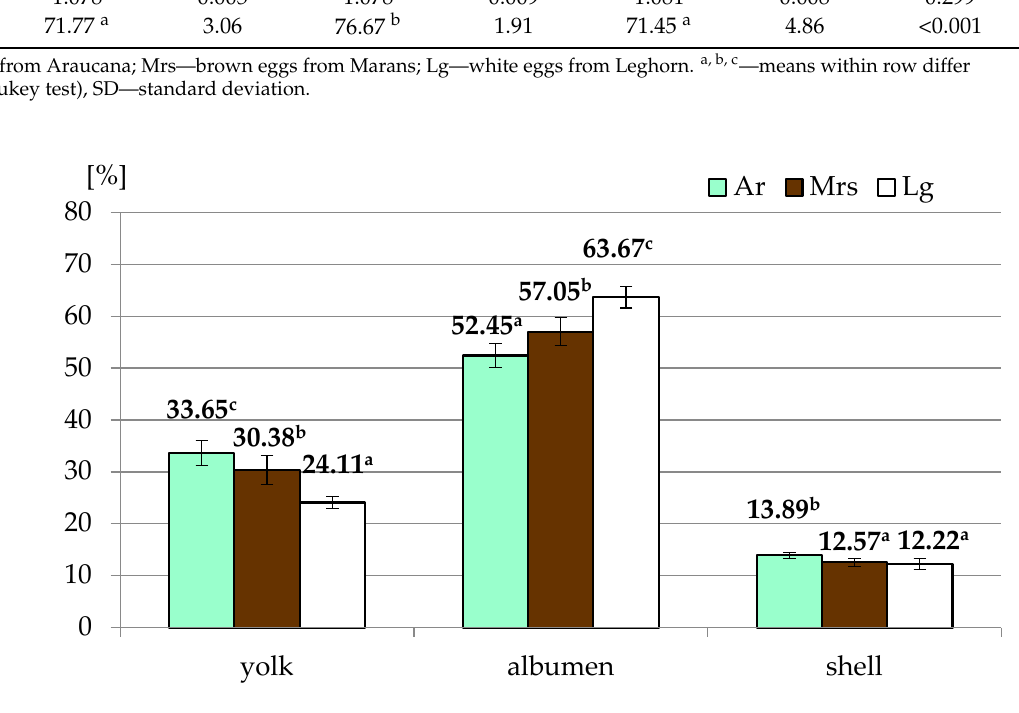
Figure 2. The proportion of particular elements of eggs from three breeds of hens differentiated by the eggshell color. Ar—green (seledine) eggs from Araucana; Mrs—brown eggs from Marans; Lg—white eggs from Leghorn; a, b, c —means within row differ significantly at p ≤ 0.05 (Tukey test).